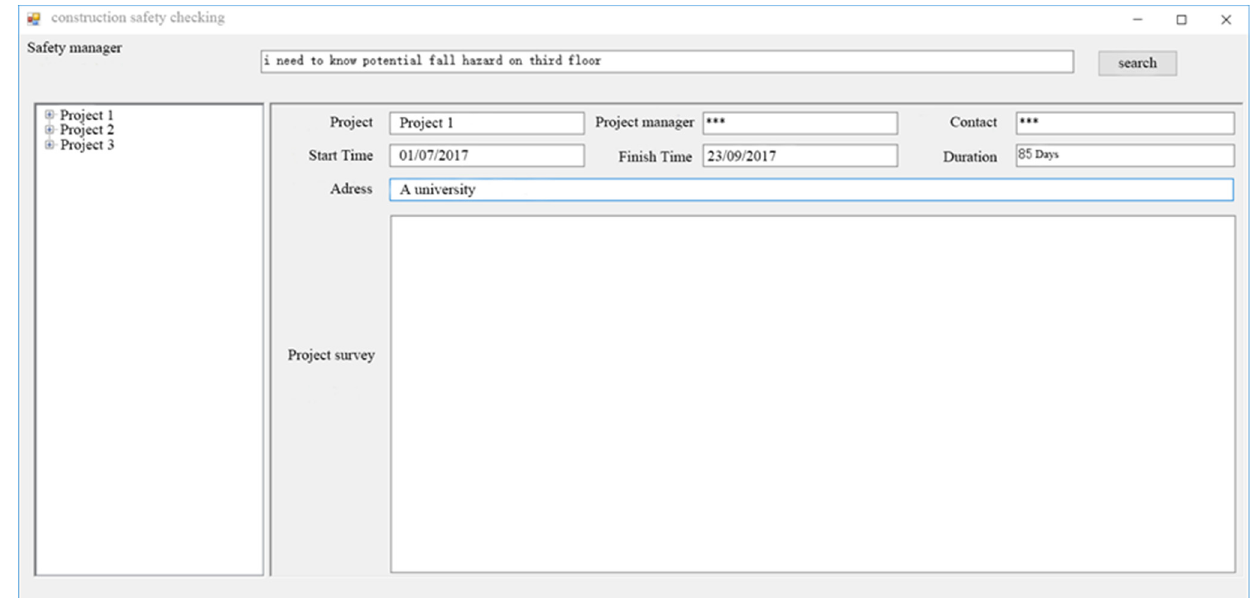
Figure 22. Landing interface of the safety risk inspection system in the construction process.